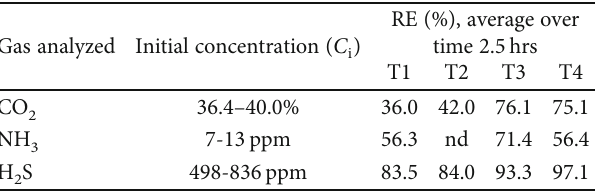
Figure 4: Biogas puri fi cation by fi lters with di ff erent soil samples: RE versus operating time. Test conditions: Q = 80 ml/min, m = 100 g, , 13 ppm for NH , and 836ppm for H S. T = 19 ° C, C 0 = 36 : 4 % for CO 2 3 2 Table 3: Soil-type performance in biogas puri fi cation (RE) average over an operating time of 2.5hrs ( Q = 80